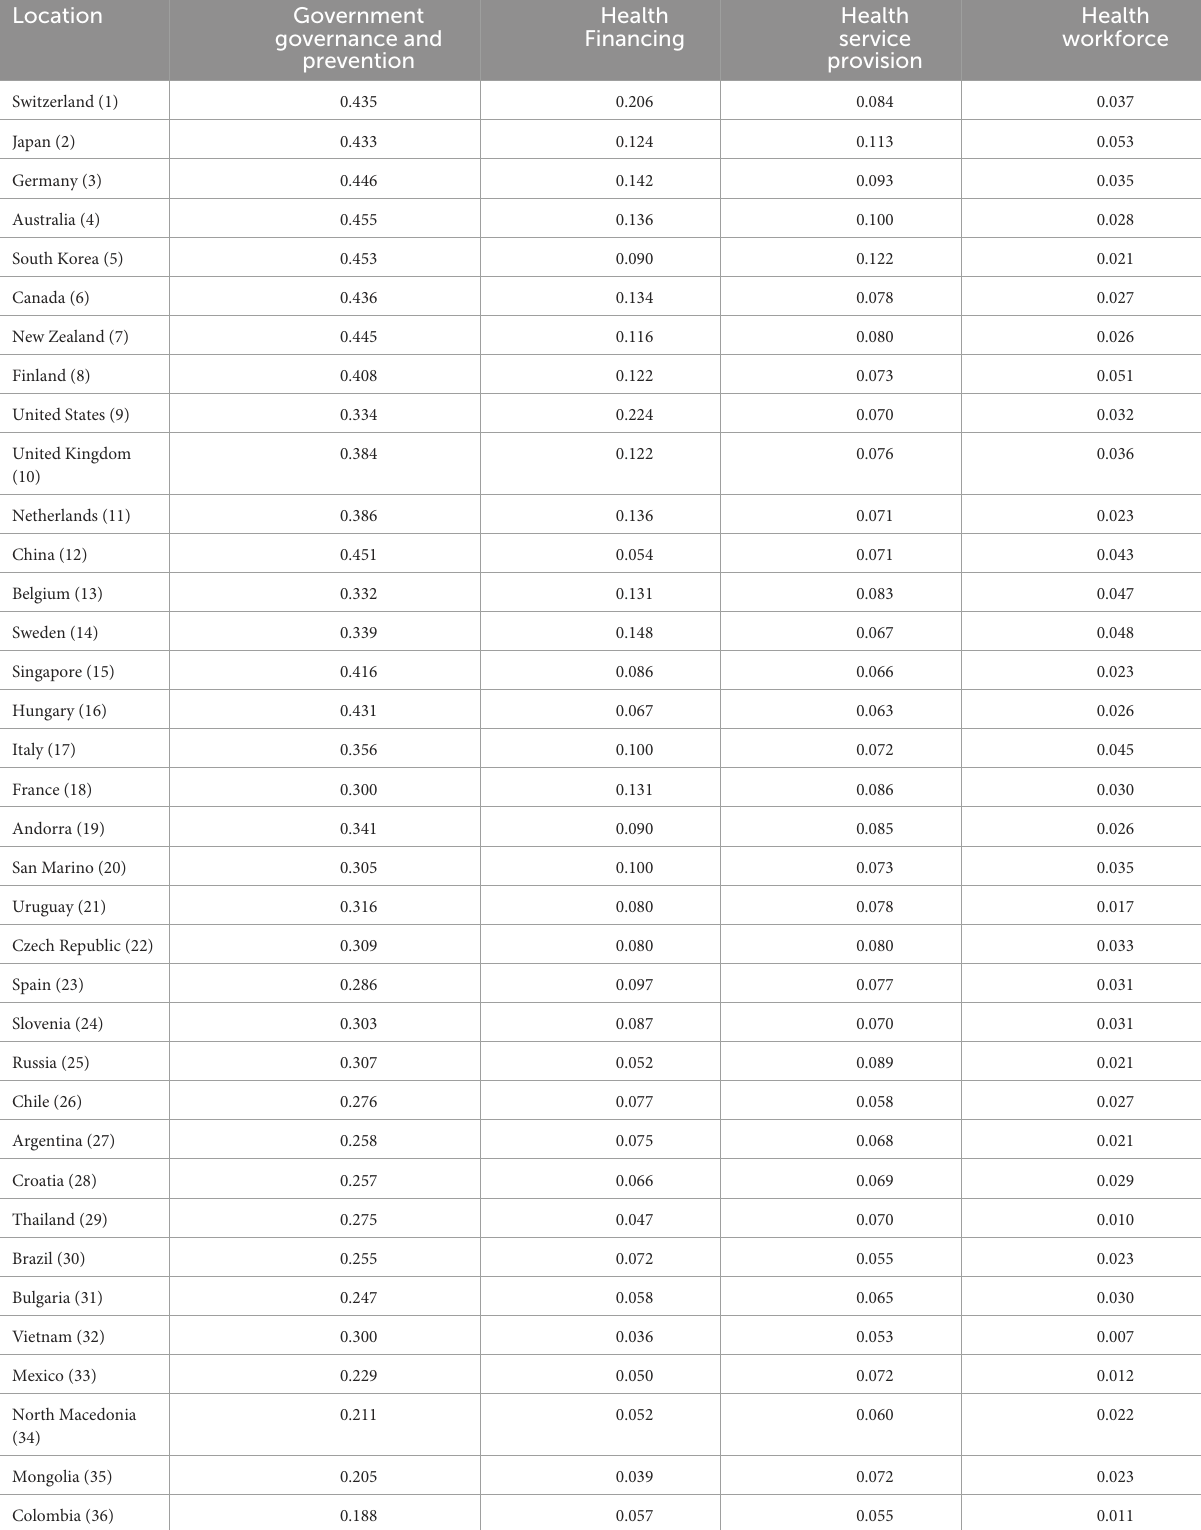
TABLE 3 Health system resilience scores in each